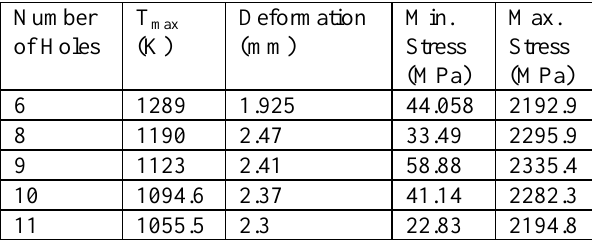
Table1: Nimonic Material simulation results Number of Holes